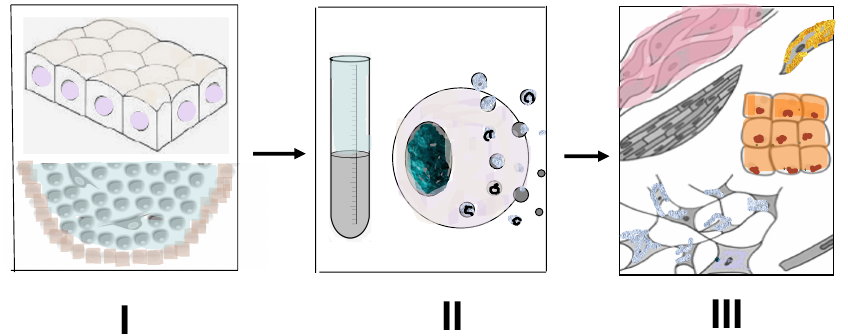
Figure 6. Main steps of an approach to stimulate tissue regeneration in higher vertebrates by the use of extracellular material of animals which have high regenerative potential. I —using of intact or blastemal tissues of amphibia and fish capable of regeneration; II —obtaining of cell and tissue extracts, secretomes, extracellular vesicles, exosomes; III —study of their effect on target cells and tissues of higher vertebrates, incapable of regeneration. Description presents in the